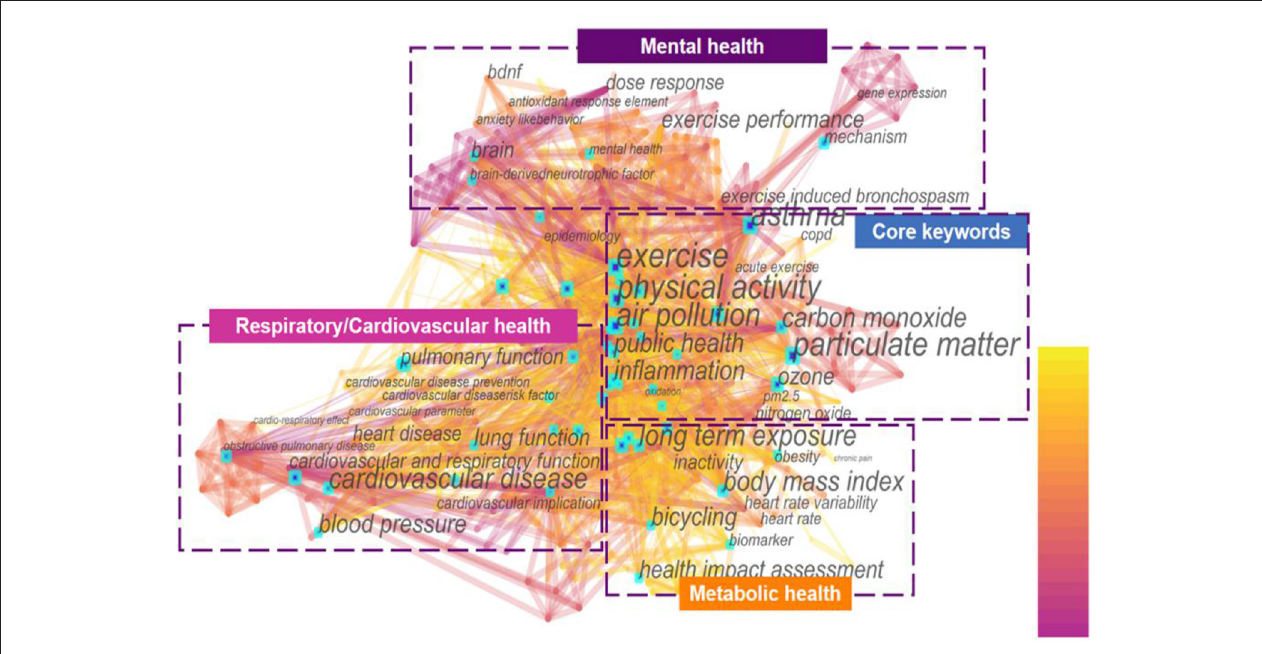
FIGURE 6 | The distribution of the co-occurrence network of keywords in the AP-PE